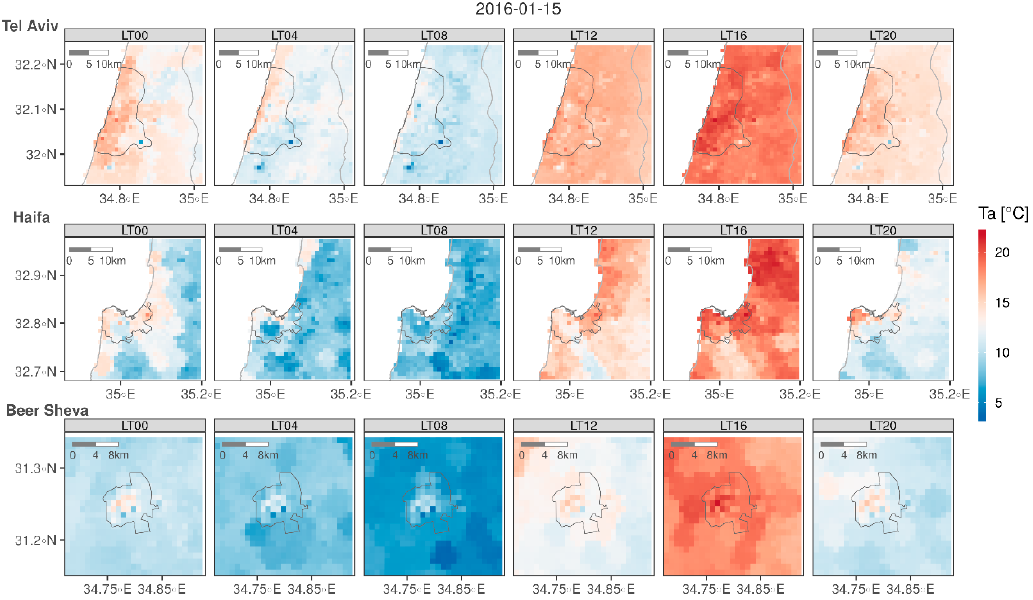
Figure 18. The simulated hourly 1 × 1 km 2 Ta at 4-h intervals for three metropolitan areas in Israel (Tel Aviv, Haifa, and Beer Sheva) on 15 January 2016.